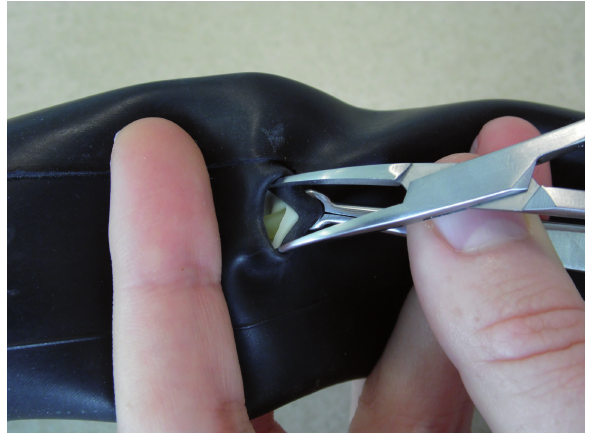
Figure 6 - Spreading the skin and fascia with the vas dissector.